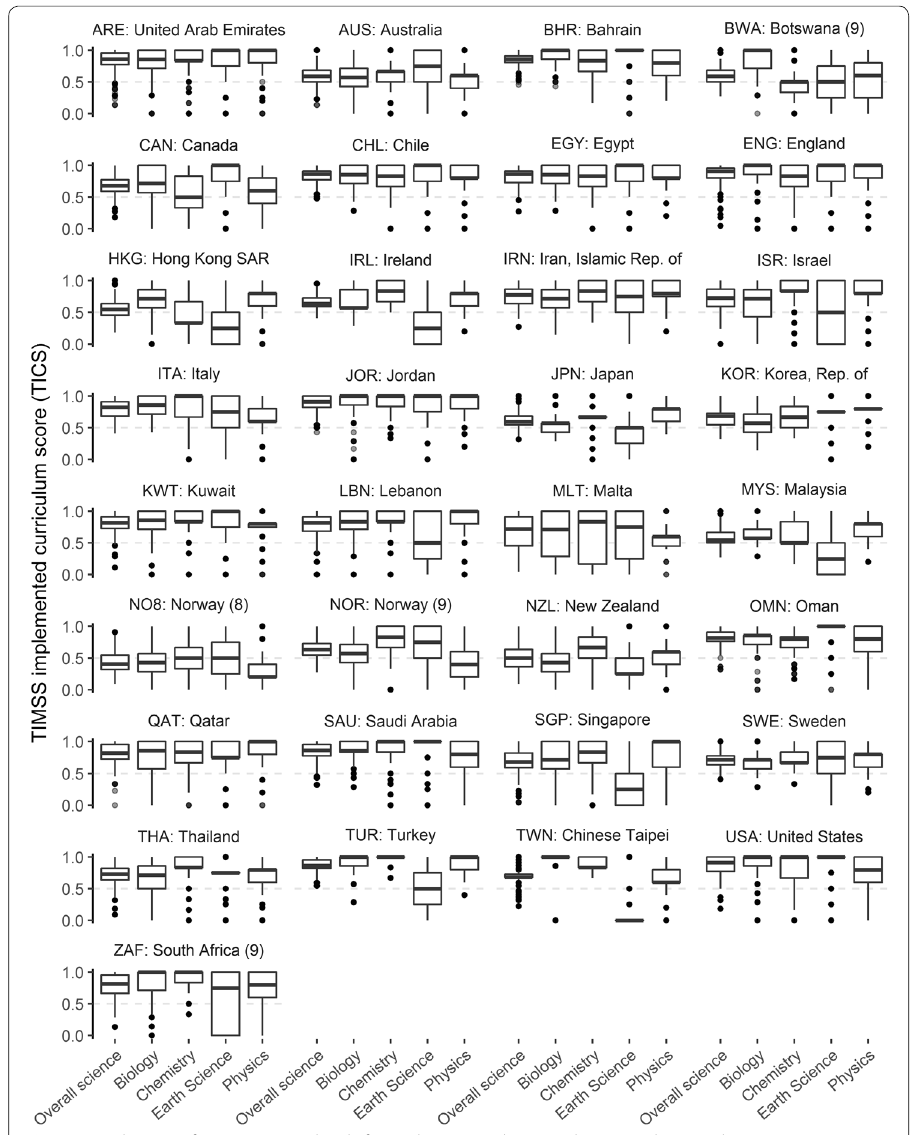
Fig. 1 Distribution of TICSs across schools for each science domain. The curriculum implementation score ranges from 0 (no implementation of the topics) to 1 (implementation of all the